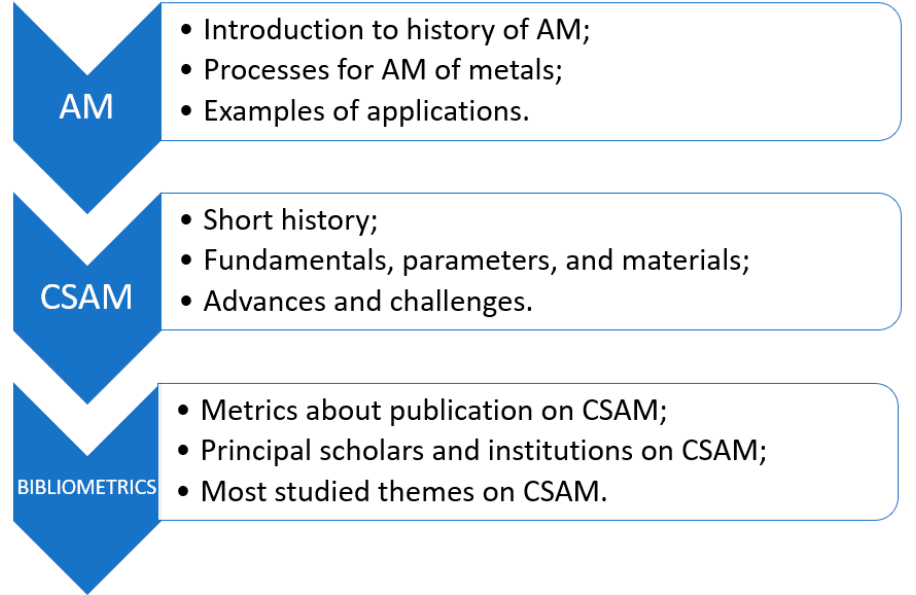
Figure 3. Flowchart of the topics presented in the work.